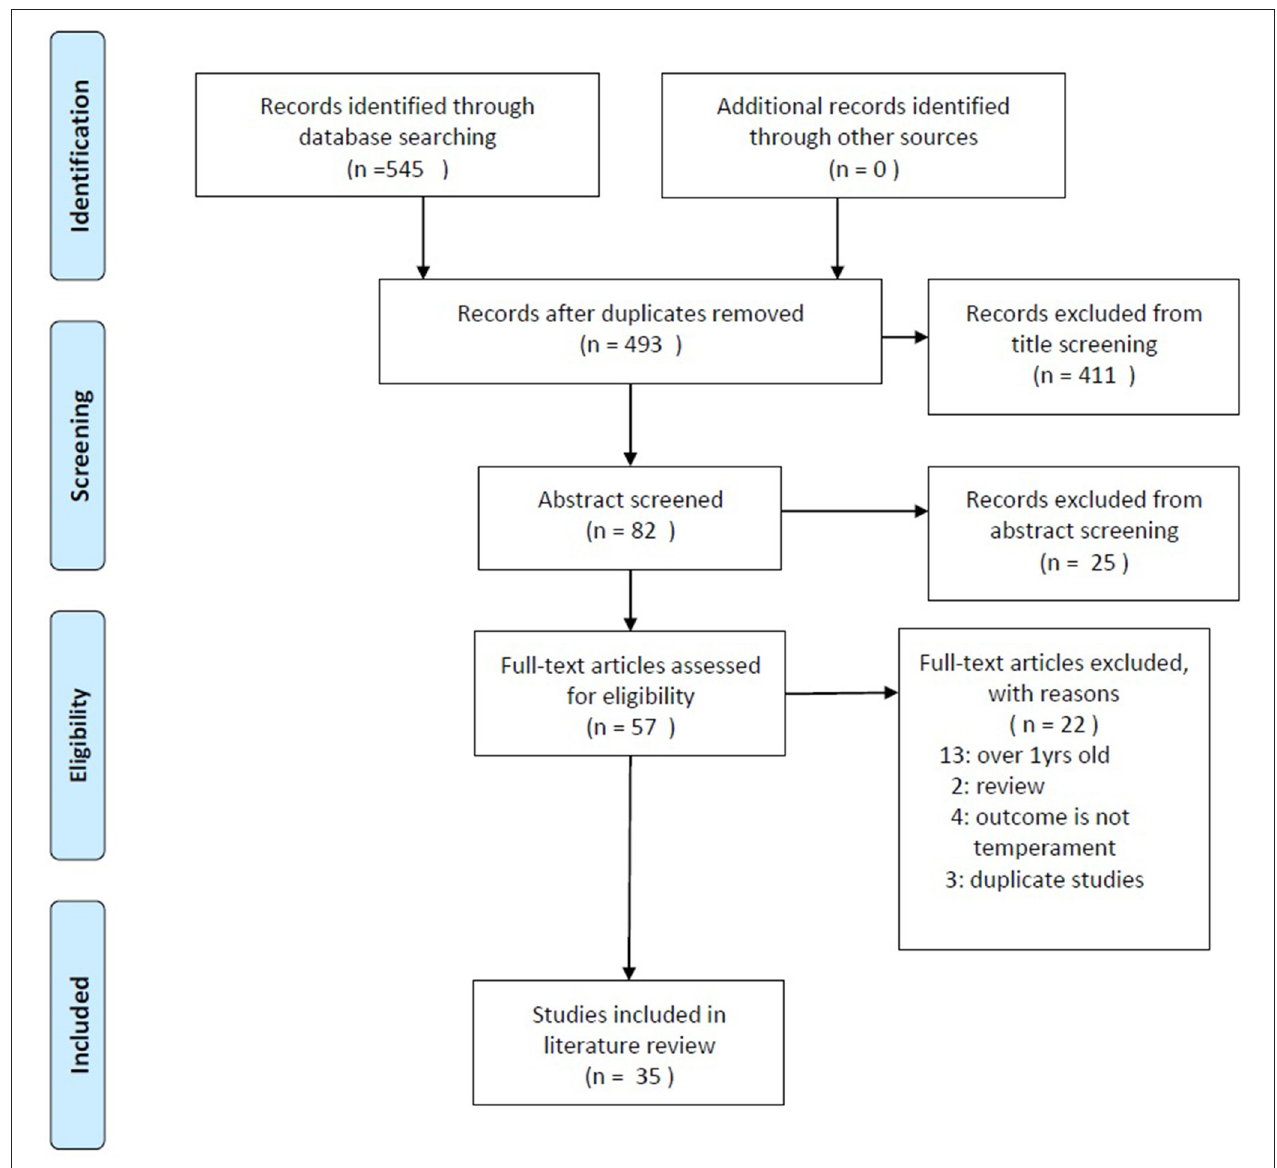
FIGURE 1 | Flow diagram of search